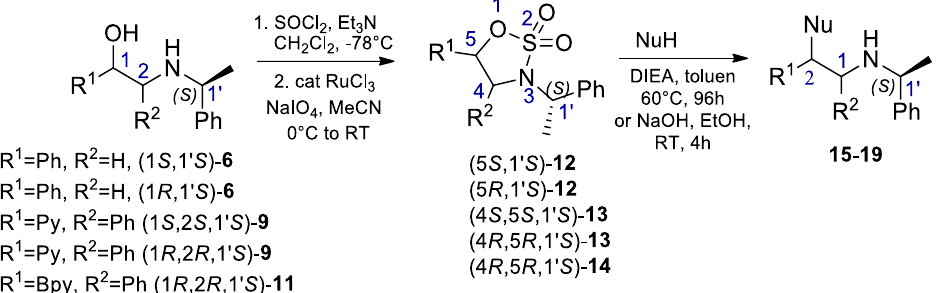
Figure 2. Molecular geometry of lowest energy structures optimized at the DFT/B3LYP/CC-pVDZ level for (4 R ,5 R , 1′ S )- 13 (left) and (4 S ,5S,1′ S )- 13 (right).